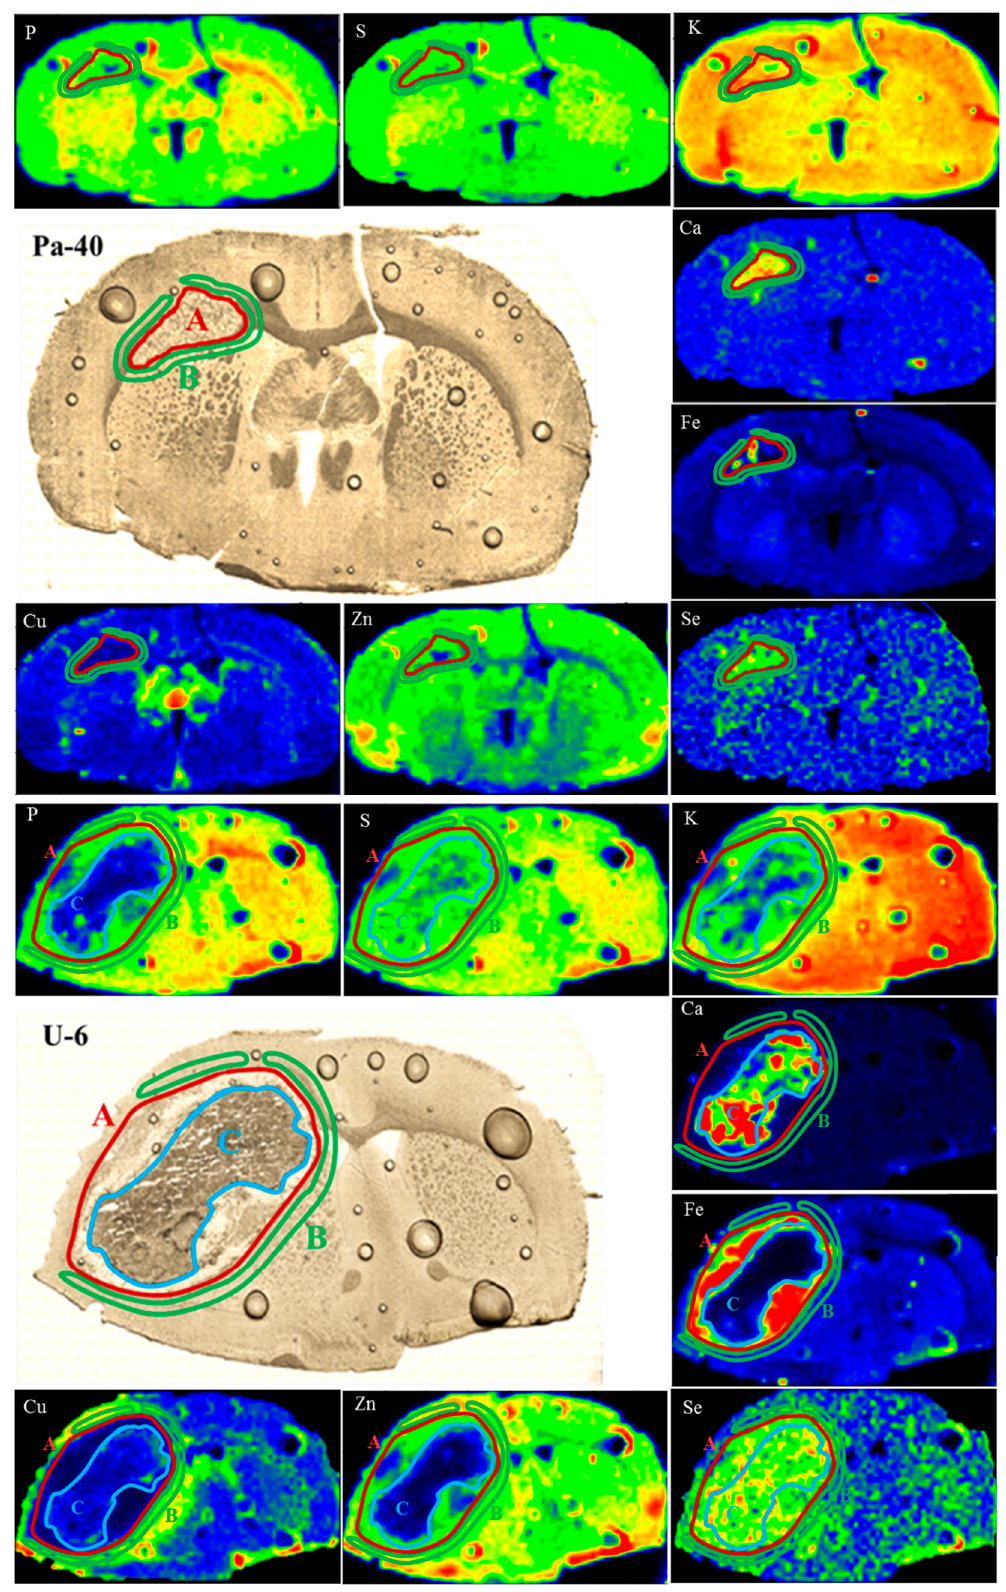
Figure 4. Regions of tumor ( A ), surrounding tissue ( B ) and tumor debris ( C ) marked in the maps of elemental distribution as well as microscopic images of brain slices taken from selected animals representing Pa and U groups.